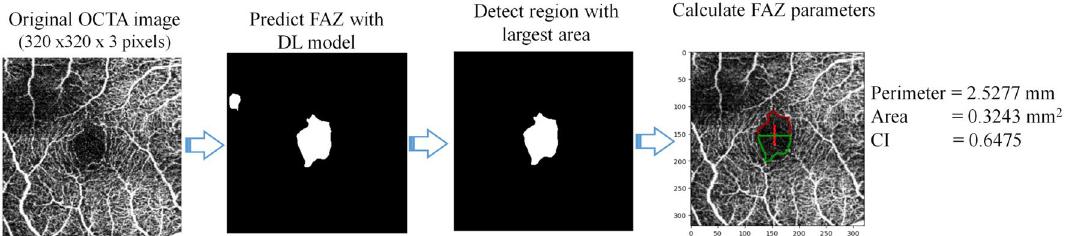
Figure 2. Proposed pipeline for automatic detection and determination of FAZ parameters (perimeter, area circularity index) using a DL model. Image size is – 3 × 3 mm 2